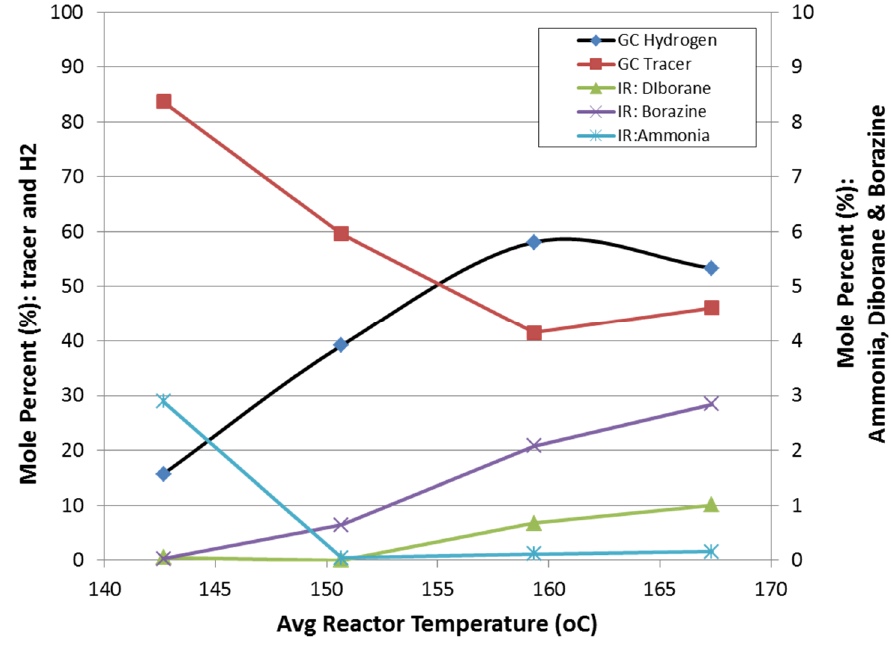
Figure 15. Reaction selectivity of ammonia borane dehydrogenation as a function of reactor temperature.